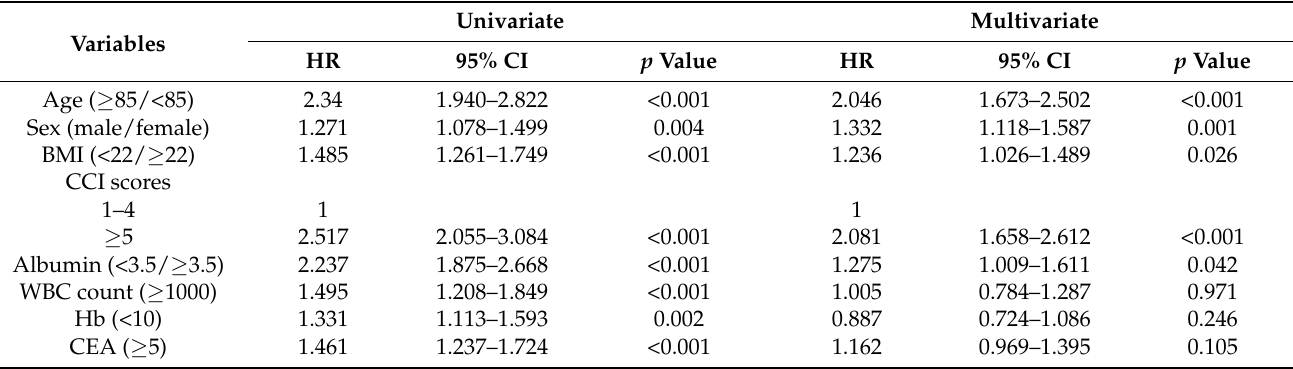
Table 5. Univariate and multivariate analyses of prognostic factors for OS in patients with CRC undergoing a curative resection.